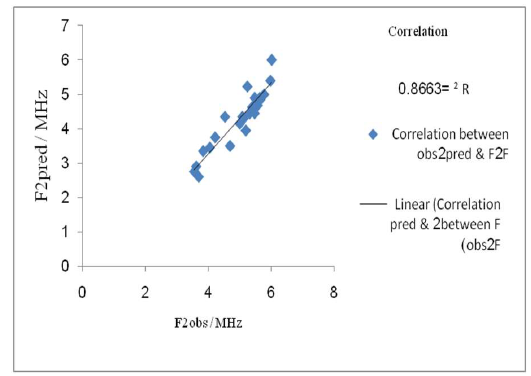
Fig. 14. Showscorrelation between F2pred and F2obs for Dourbes